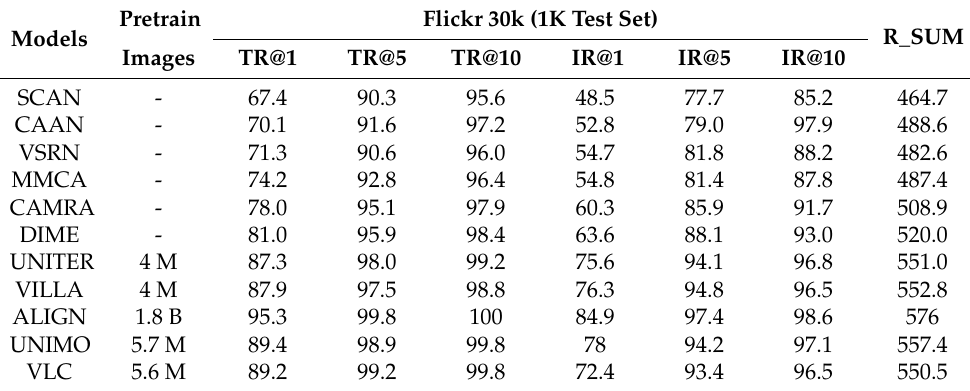
Table 5. Cross-modal retrieval performance comparison on Flickr 30k (1K test set). Models